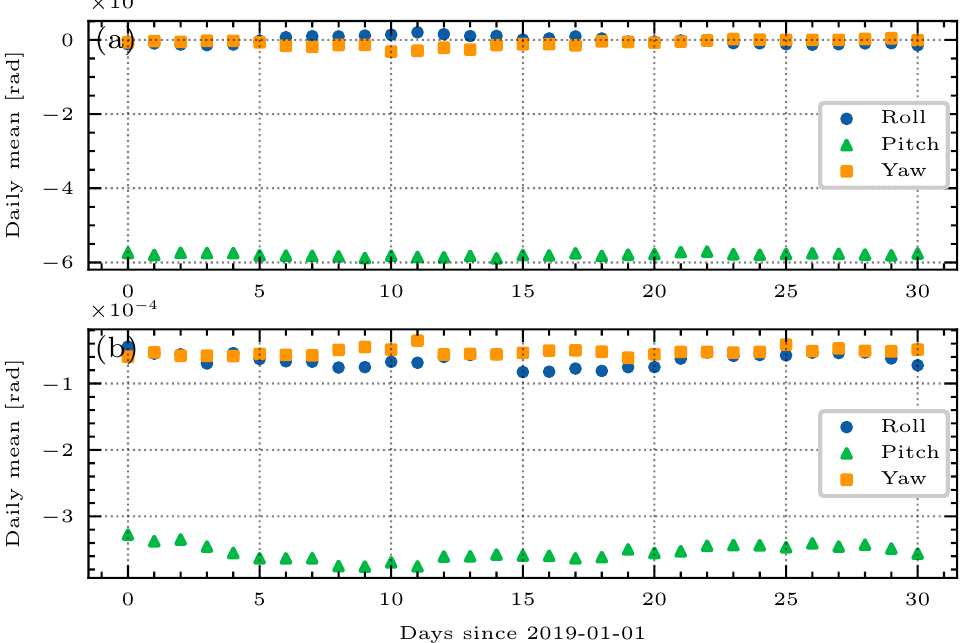
Figure 9. Time series of the daily mean of (JPL minus HUGG-01) on January 2019. ( a , b ) denote results of GRACE-FO Sat-C and Sat-D,